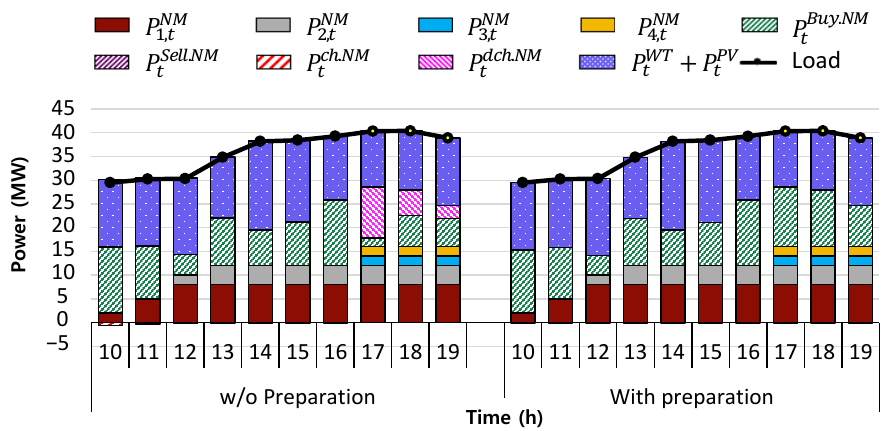
with and without preparation.